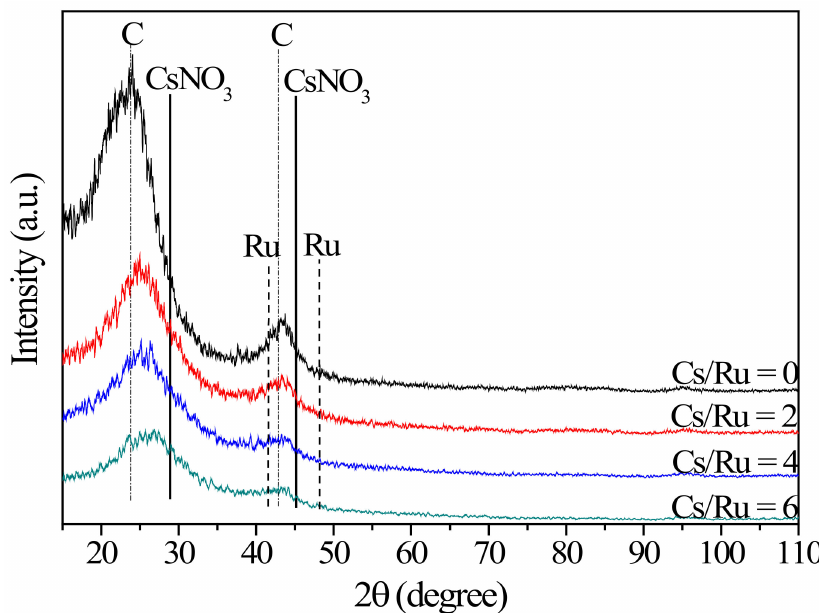
Figure 5. The XRD patterns for Ru/C catalysts promoted with different overall molar ratios of Cs/Ru at a reaction temperature of 350 ◦